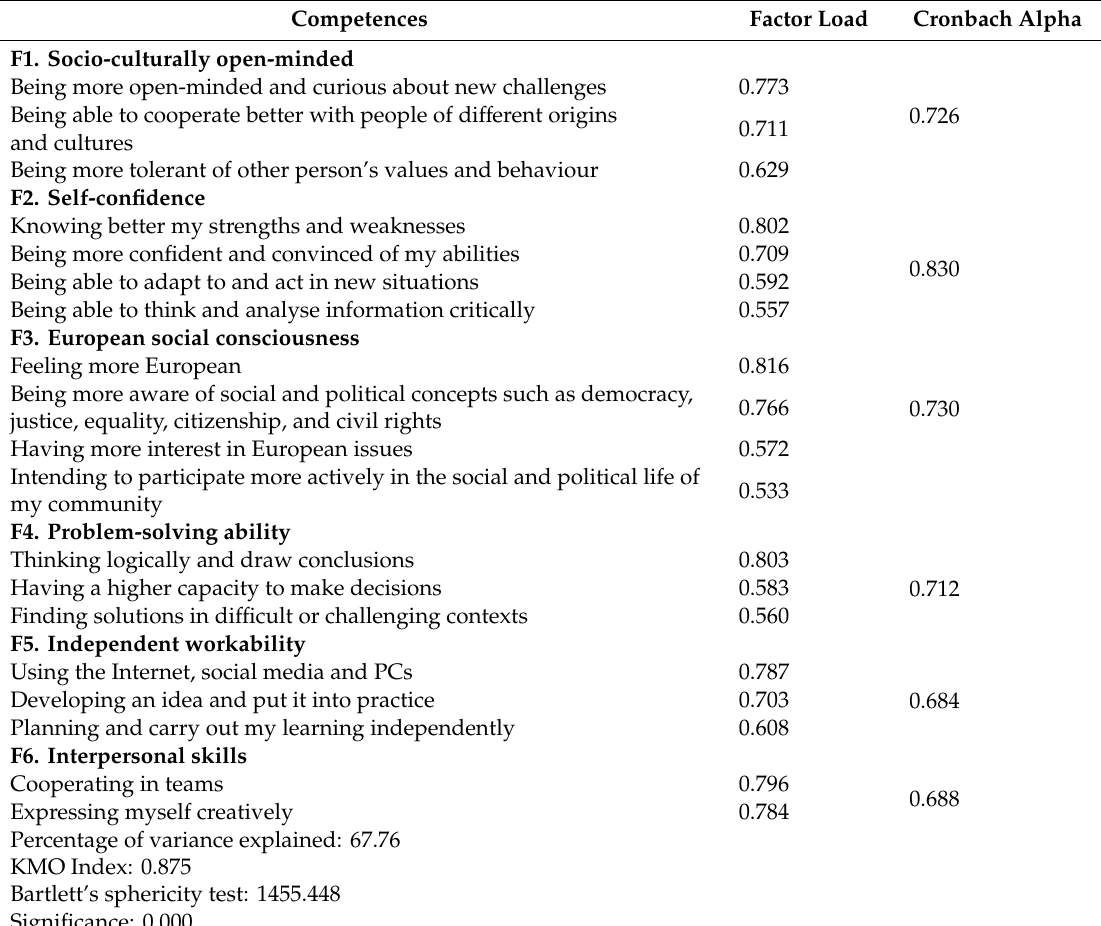
Table 4. Results of the exploratory factor analysis for the competences developed during the Erasmus + .